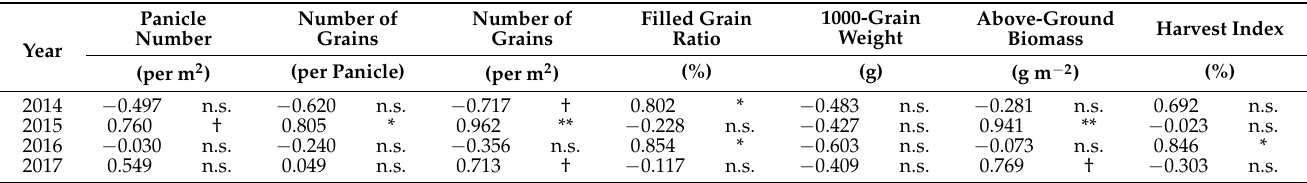
Table 5. Correlation coefficients obtained from the regression analyses between grain yield and different yield components in Basmati 370 grown under continuous flooding (CF) and alternate wetting and drying (AWD) during 2014, 2015, 2016, and 2017.